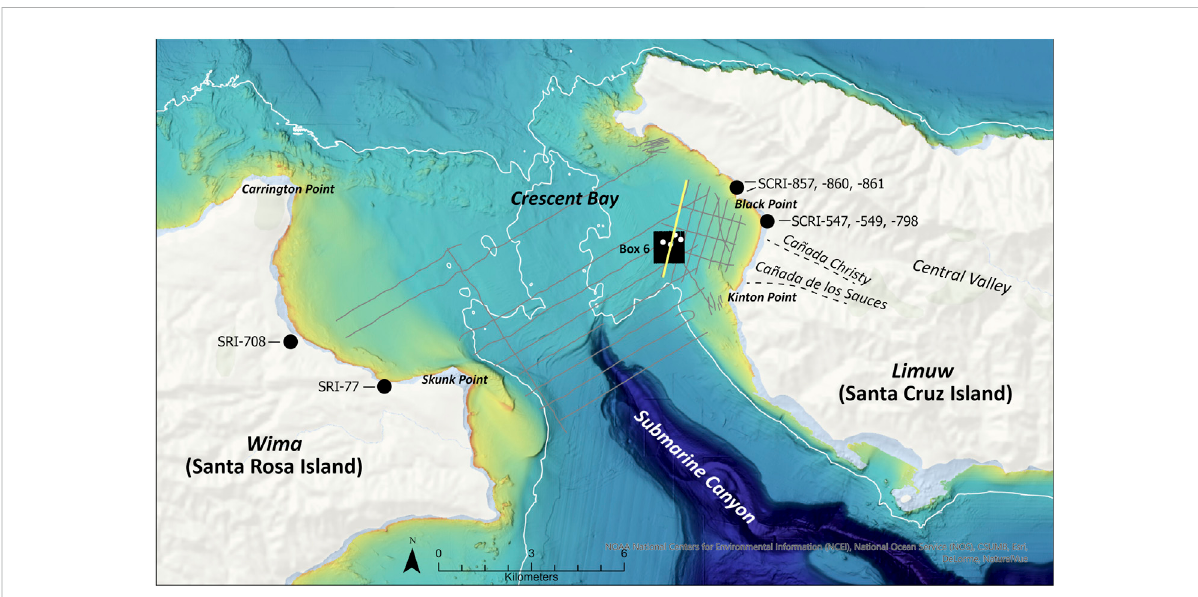
FIGURE 3 Santa Cruz Passage and Crescent Bay research area. Grey lines are transects from broad Chirp survey. Yellow line is the seismic line where the paleovalley was identi fi ed (shown in Figure 2). Black lines are the tight-grid spaced Chirp transect within the 1 km 2 box 6. White dots are the core locations within Box 6. Black circles are general locations of archaeological sites mentioned in the text. Dashed black lines indicate locations of canyons mention in text. White line is the 40 m bathymetric contour, showing assumed extent of Santarosae at ~9,000 years